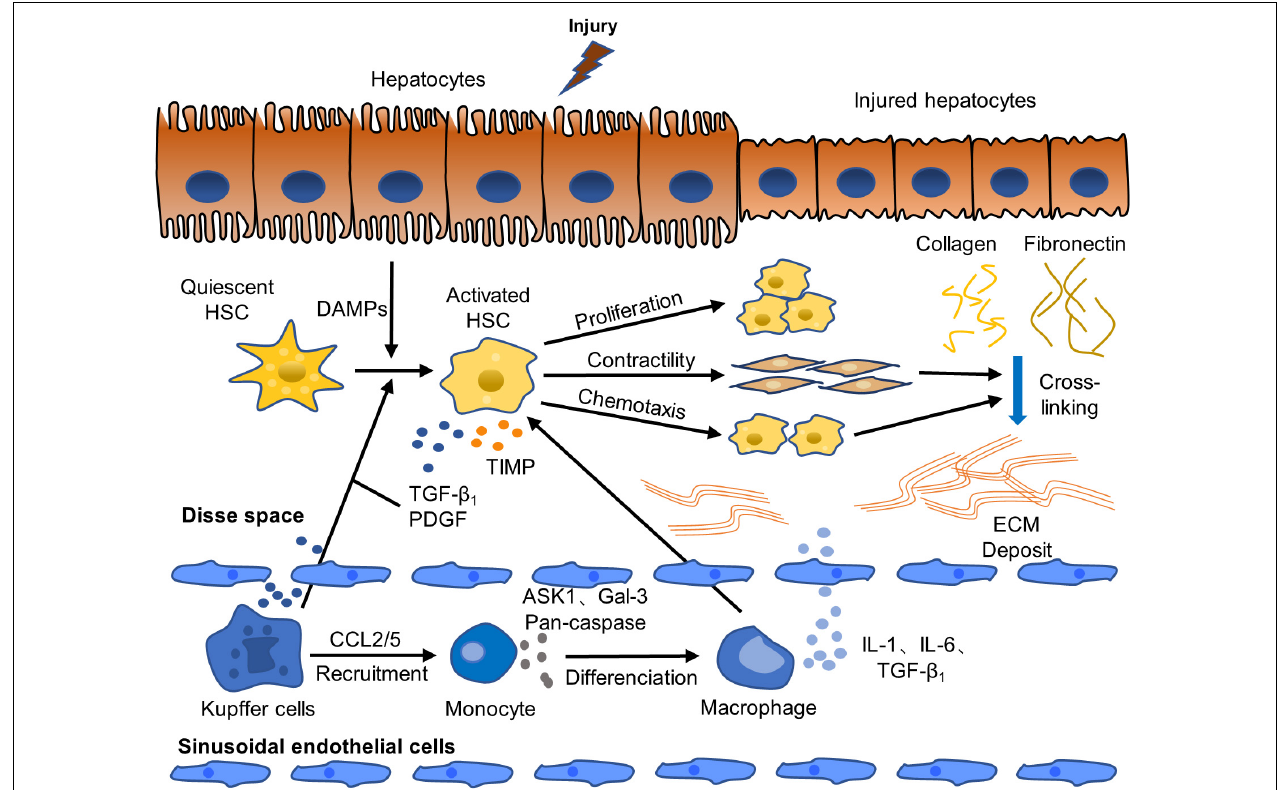
FIGURE 1 | Pathogenesis of liver fibrosis. Activation of HSCs is a crucial step of the occurrence and progression of liver fibrosis. Quiescent HSCs are activated to fibrogenic phenotype by DAMPs released by injured hepatocytes. Activated HSCs are continuously activated and proliferated by paracrine and autocrine. They secret abundant fibrogenic cytokines and produce excessive ECM, which causes the break of the balance of pro-fibrosis/anti-fibrosis mechanism. The pro-fibrosis mechanism leads to the abnormal formation of scar and eventually induces liver fibrosis (Tacke and Weiskirchen, 2012; Roehlen et al.,